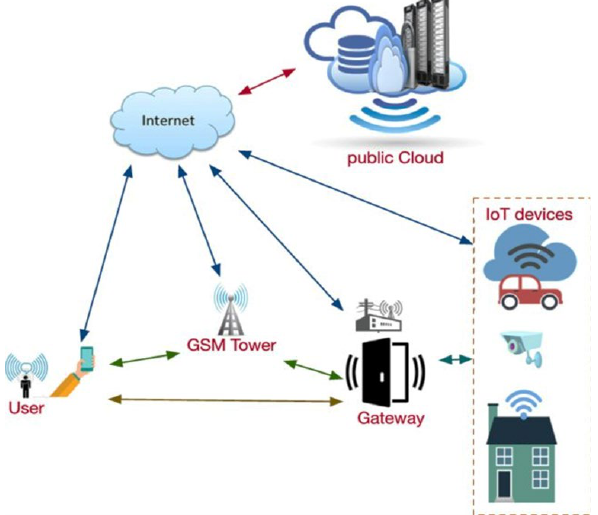
Figure 5. IoTs Supported Mobile